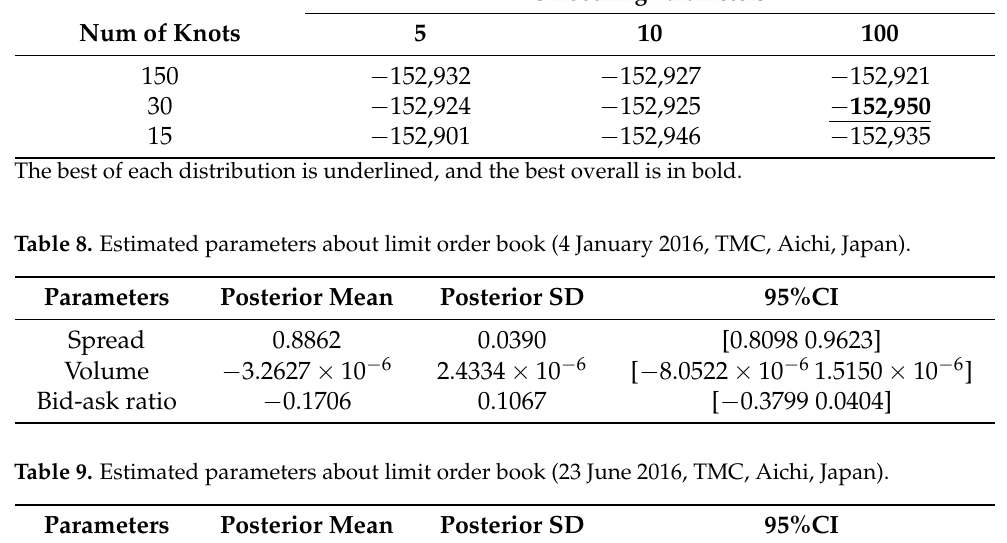
The best of each distribution is underlined, and the best overall is in bold. Table 6. DIC for Weibull distribution (27 July 2016, TMC, Aichi, Japan). Num of Knots